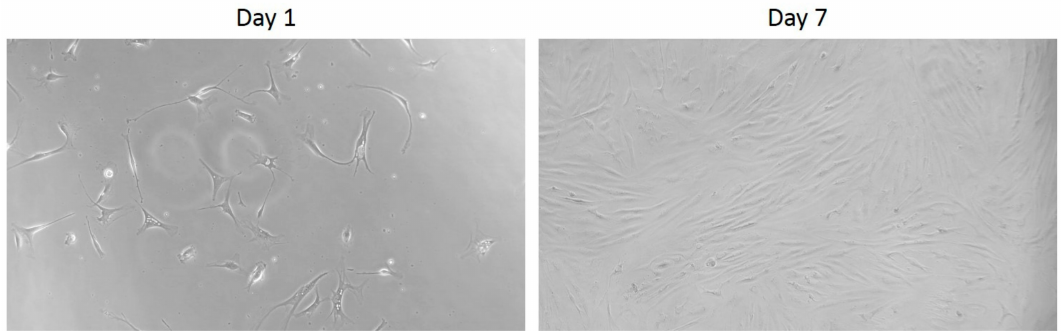
Figure 2. Microscopic images of the tenocytes cultured on day 1 and day 7.